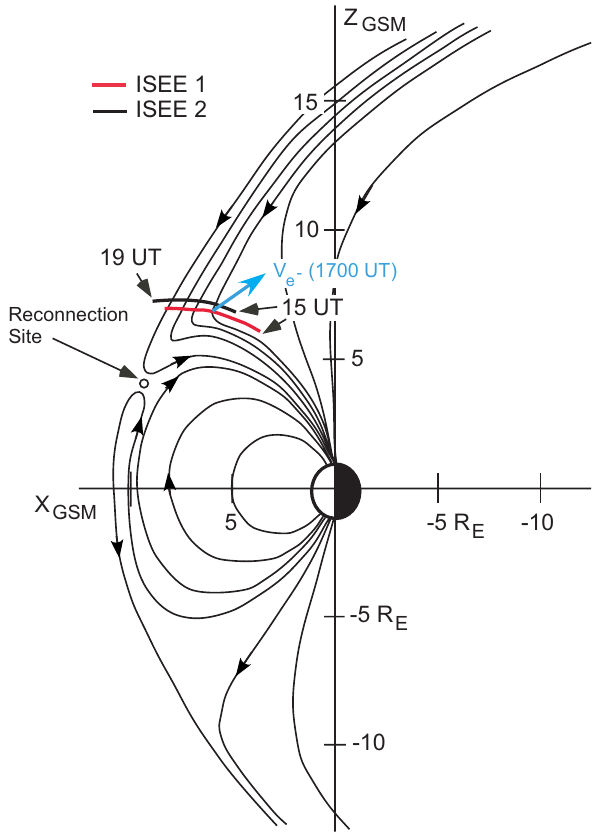
Fig. 1. Schematic of the magnetospheric magnetic field configu- ration encountered by the ISEE spacecraft from 15:00–19:00UT. A low latitude reconnection site connects magnetic field lines from the northern magnetosheath with previously closed field lines in the magnetosphere. The spacecraft encounter these open field lines as they convect poleward and tailward from the reconnection